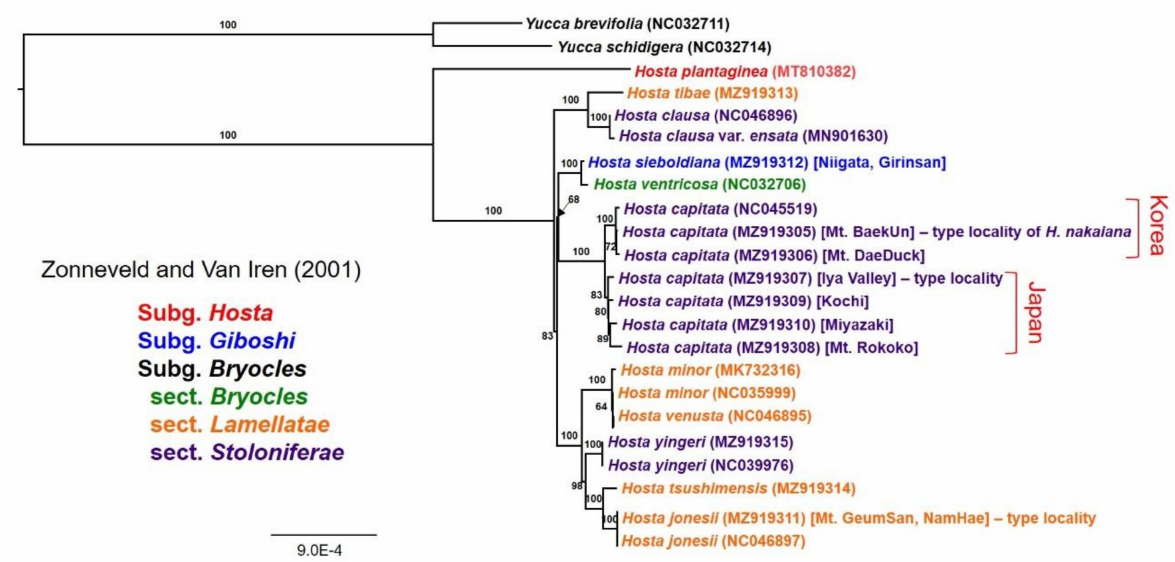
Figure 5. The maximum-likelihood (ML) tree using IQ-TREE inferred from 21 Hosta accessions and two Yucca species. The complete plastomes of 21 Hosta accessions are labeled in red (subg. Hosta ), blue (subg. Giboshi ), green (subg. Bryocles , sect. Bryocles ), orange (subg. Bryocles , sect. Lamellatae ), and purple (subg. Bryocles , sect. Stoloniferae ). The bootstrap value based on 1000 replicates is shown on each node. Two Yucca species were used as an outgroup, and columns on the right indicate the two habitats of Japan and